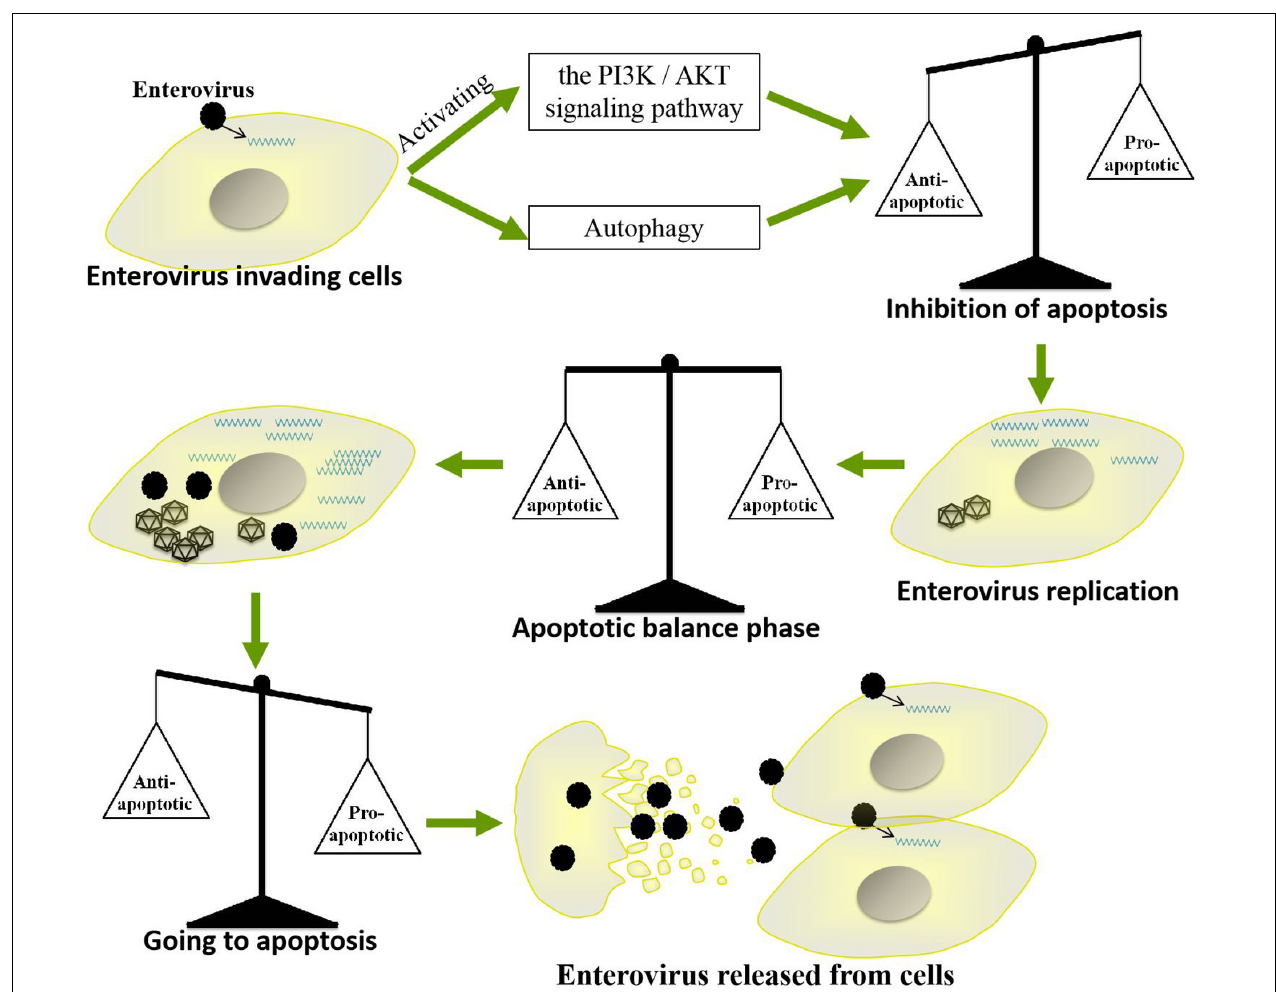
FIGURE 5 | Mechanism by which enteroviruses balance apoptosis. Enteroviruses inhibit apoptosis in the early stages of infection to prolong their replication time but induce apoptosis in the late stage of infection to facilitate the release of progeny